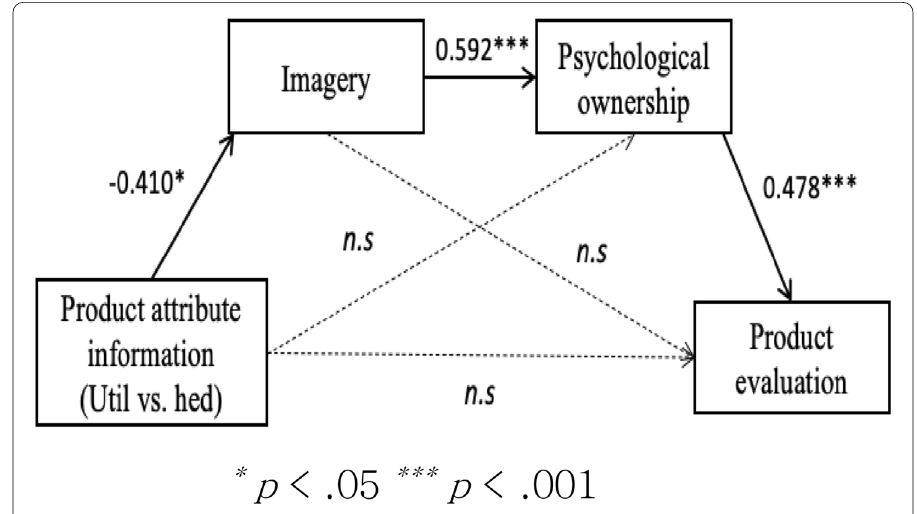
Fig. 6 Sequential mediation of imagery and psychological ownership in the effect of product attribute information on product evaluation